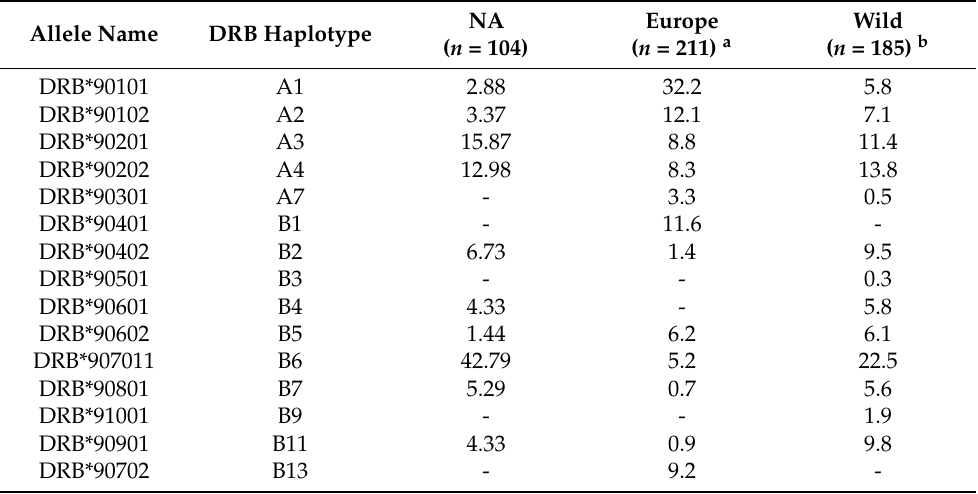
Table 1. Relative frequencies of DLA-DRB1 haplotypes identified in the NA population of APD (this study) compared to European captive facilities and wild populations in southern